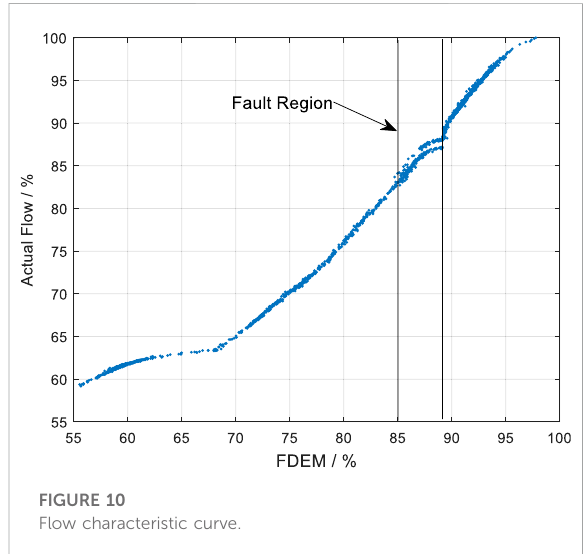
FIGURE 10 Flow characteristic